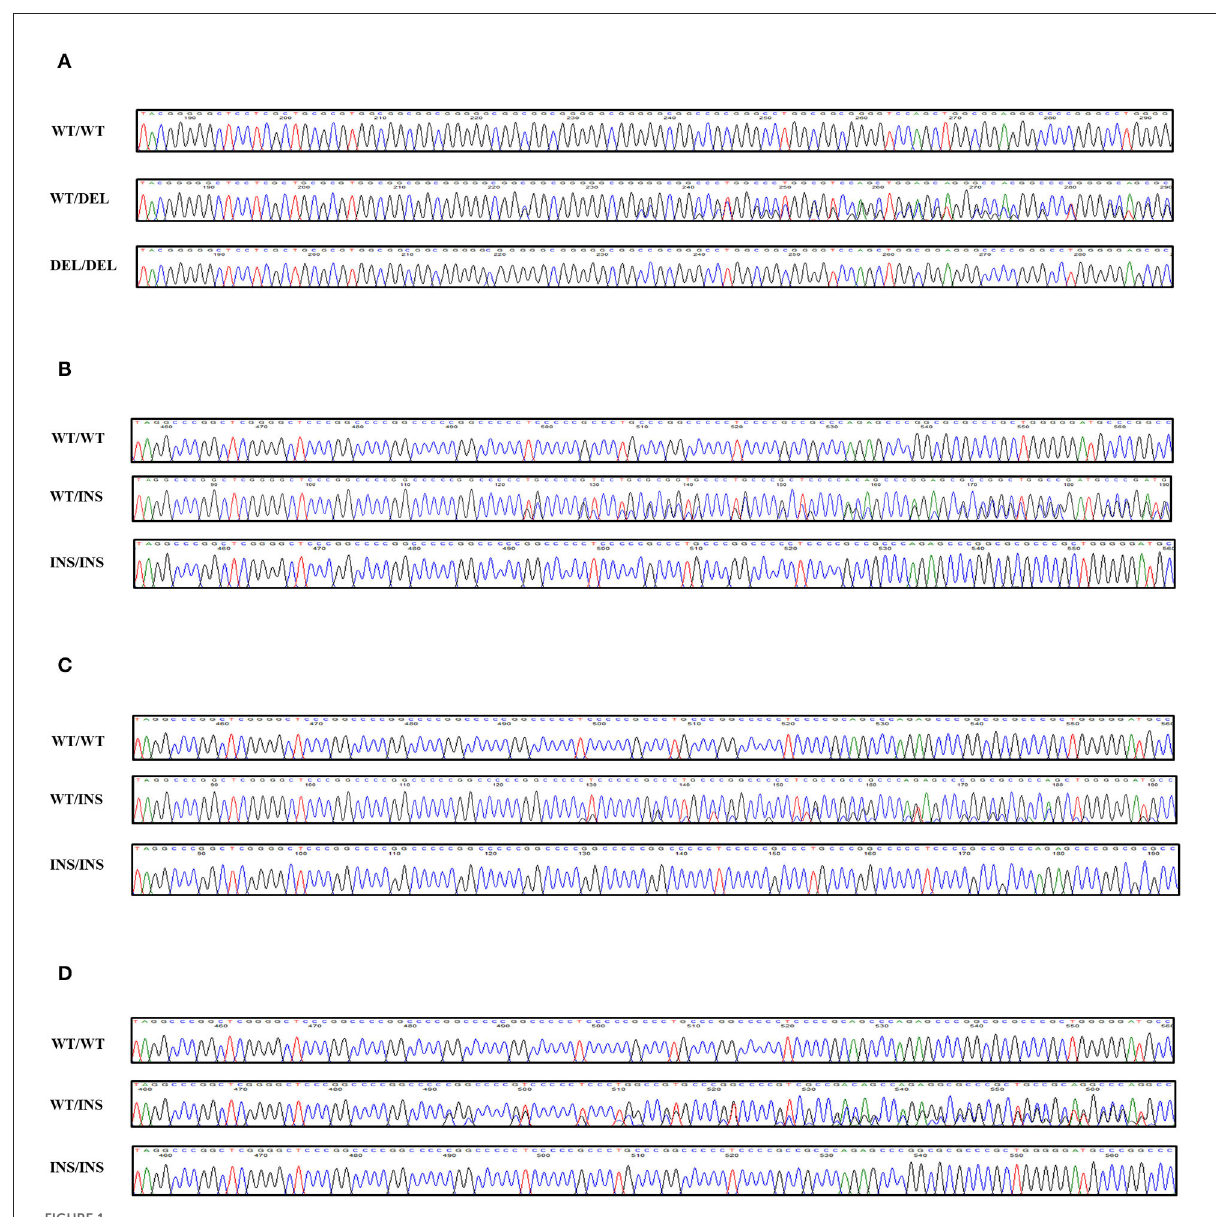
FIGURE1 Novel genetic polymorphisms of the canine shadow of prion protein gene ( SPRN ) in the present study. (A) c.209_214DelCGGCGG (70_71DelAA). (B) c.444 + 30_444 + 31InsGGCCCCC. (C) c.444 + 30_444 + 31InsGGCCCCCGGCCCC. (D) c.444 + 31_444 + 32InsGGCCCC. Four colors show individual bases of the DNA sequence (blue: cytosine, red: thymine, black: guanine, green: adenine). WT, wild-type allele of the canine SPRN gene; DEL, deletion allele of the canine SPRN gene; INS, insertion allele of the canine SPRN gene.